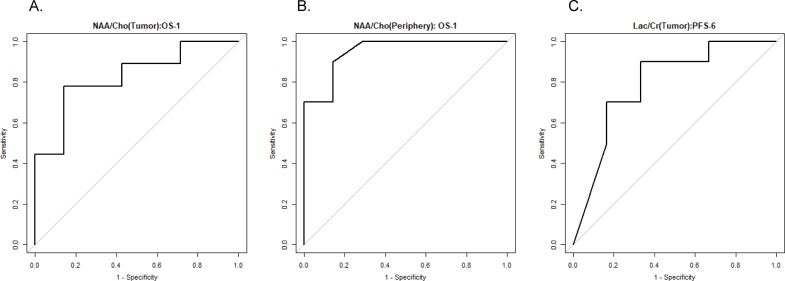
ROC curves with the corresponding AUC for predictors (A. tumor NAA/Cho, B. peripheral NAA/Cho, and C. tumor Lac/Cr) using 1-year overall survival (OS-1) and of 6-month progression free survival (PFS-6).